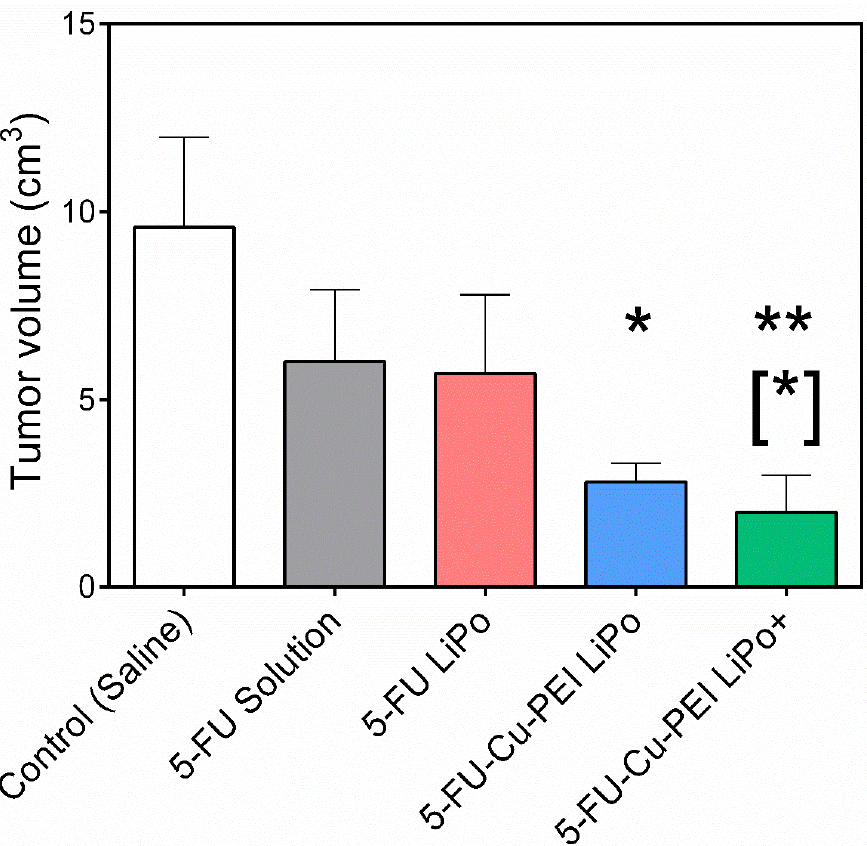
Figure 6. Tumor volume of rats administered 5-FU formulations versus a saline control on day 12, following five consecutive days of dosing. Statistical significance is represented as * p < 0.05, ** p < 0.01 in contrast to the saline control; [*] p < 0.05 in contrast to the 5-FU solution. Data represented as mean ± S.D., n = 6.